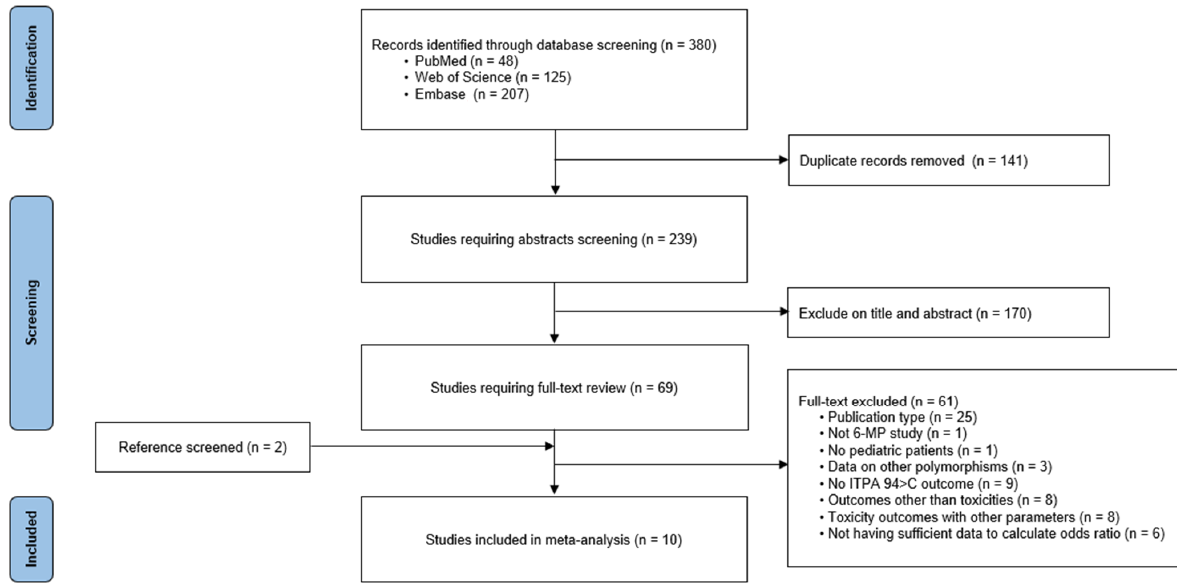
Figure 1. PRISMA flow diagram for the meta-analysis.